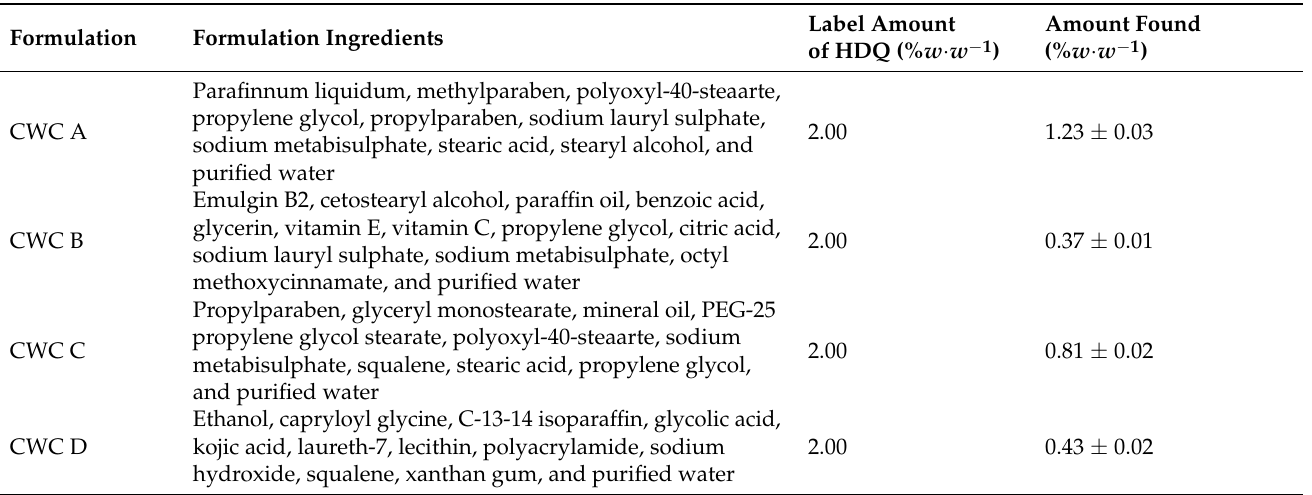
Figure 3. HPTLC chromatogram of HDQ in ( A ) CWC A and ( B ) CWC B. Table 6. Determination of HDQ in four different commercial whitening creams (CWCs) using an ecologically sustainable HPTLC method (mean ± SD; n =